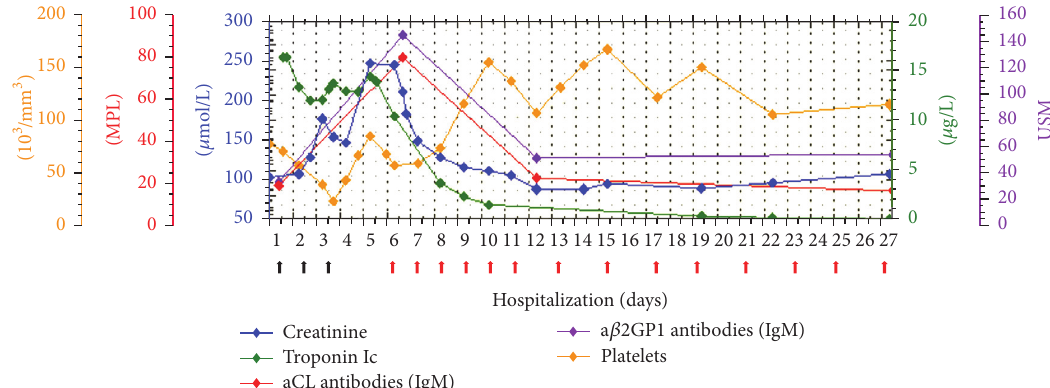
Figure 2: Improvement in laboratory parameters upon initiation of therapeutic plasma exchange. Plasma exchange was initiated on hospital day 6 (red arrows). Methylprednisolone pulses (black